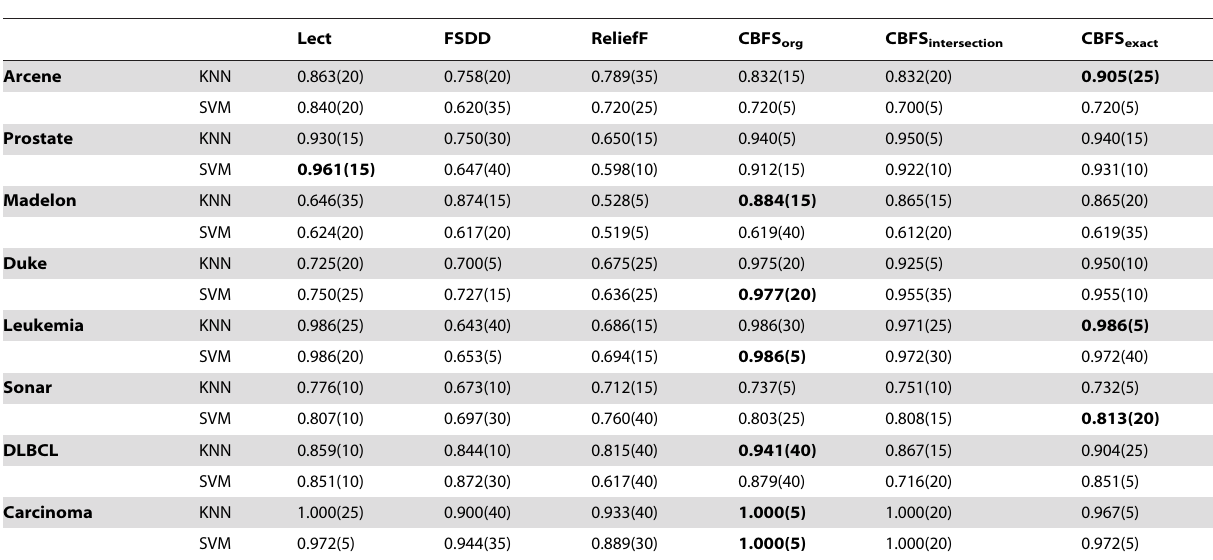
Table 2. Best classification accuracies and number of features to produce accuracies.